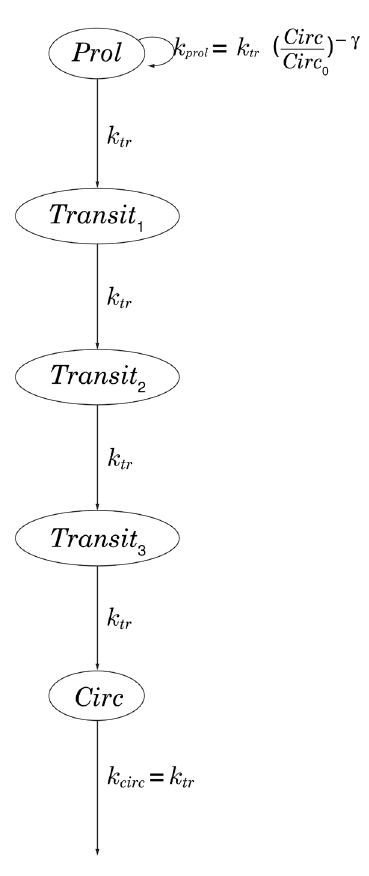
Figure 2. Chemotherapy-induced myelosuppression model of Friberg et al. [10, Table 4]. Prol : proliferative compartment; Transit maturation compartments; Circ : systemic circulation; k rate; k : rate of proliferation of progenitor cells, regulated by a prol negative-feedback loop parametrized by γ >